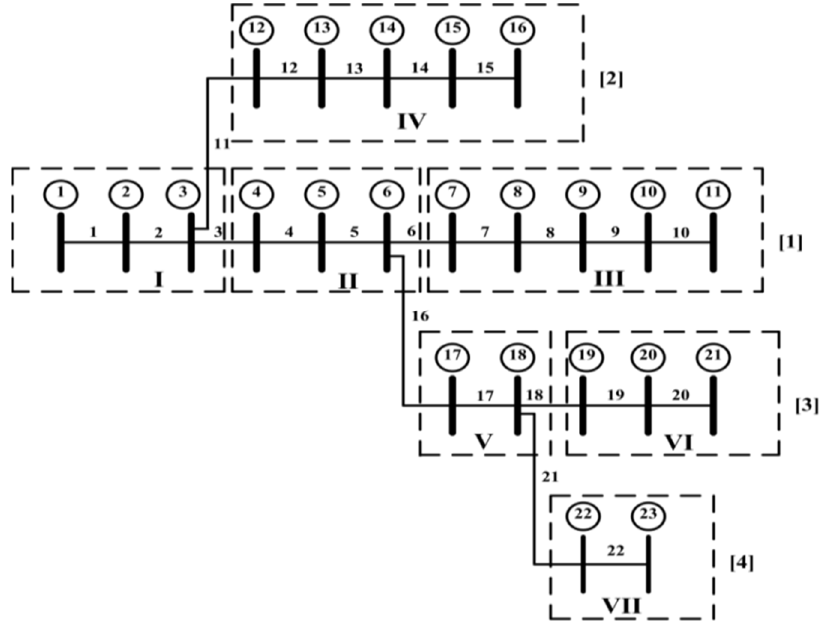
Figure 3. Divided sections for sample distribution network.